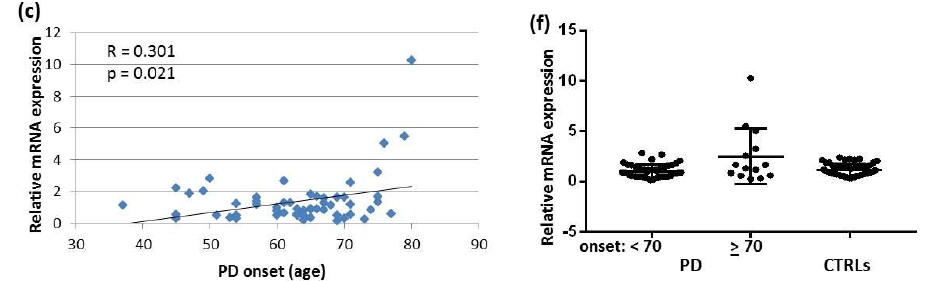
Figure 5. Correlation between the age of PD onset and ( a ) SNCAtv1, ( b ) SNCAtv2, and ( c ) SNCAtv3 expression. SNCA expression in two age-at-onset dependent subgroups compared to controls: ( d ) SNCAtv1; ( e ) SNCAtv2; ( f ) SNCAtv3. * p <0.05, ** p < 0.01.